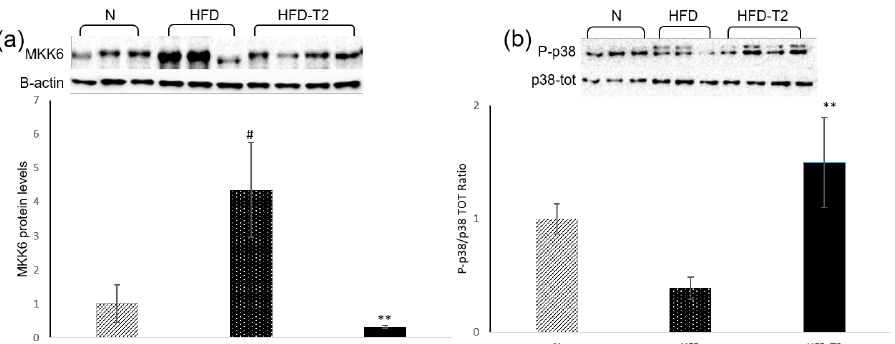
Figure 8. Effects of T 2 administration on MKK6 and P-p38 in sWAT. ( a , b ) Immunoblot and densitometry showing relative expression of MKK6, P-p38, and total p-38 in sWAT lysates. Values are means ± SEM of five independent experiments. N = 5, # p < 0.05 vs. N; ** p < 0.05 vs. HFD.